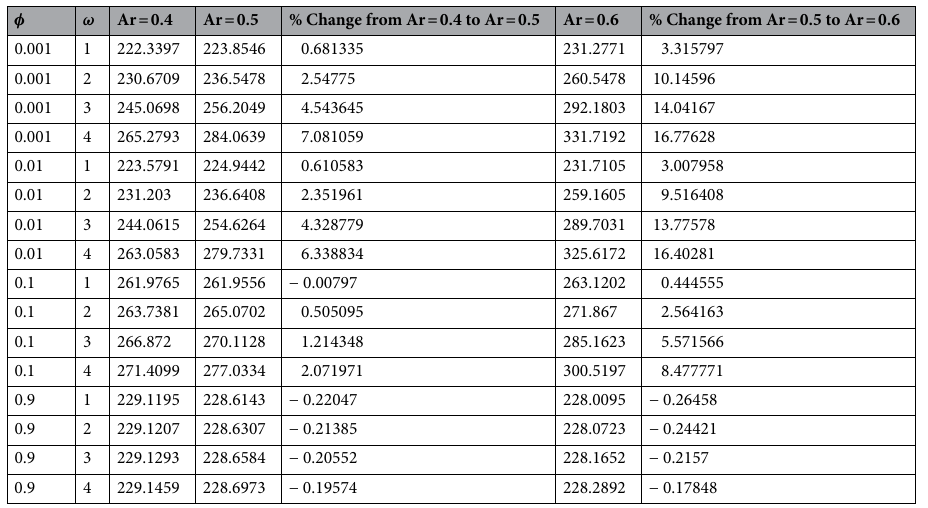
Table 3. The details of the average number at the middle plane of the annular tube with percentage increase when switching from one aspect ratio to near